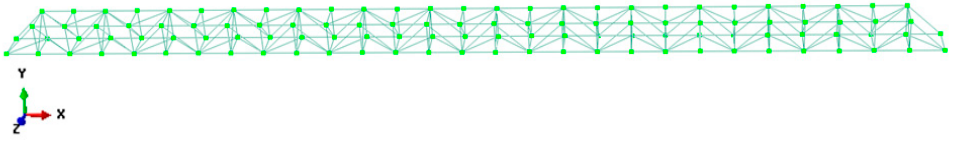
Figure 2. Finite element model with 355 rods.